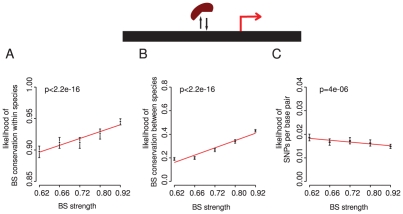
Stronger binding sites more closely matching the intrinsic binding preference for a TF are more conserved within and between species.The proportion of conserved sites is shown for six equally populated bins of sites within (A) and between (B) species. The number of sequence changes per base pair within species is also shown (C).